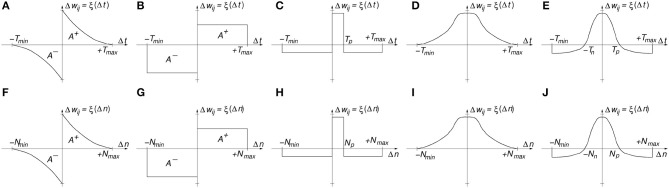
(A) Classic time-based STDP (B) Rectangular time-based STDP, (C) Narrow Potentiation time-based STDP, (D) Symmetric Hebbian Potentiating only time-based STDP, (E) Symmetric Hebbian with Narrow Potentiation time-based STDP, (F) Classic order-based STDP (G) Rectangular order-based STDP, (H) Narrow Potentiation order-based STDP, (I) Symmetric Hebbian Potentiating only order-based STDP, (J) Symmetric Hebbian with Narrow Potentiation order-based STDP.